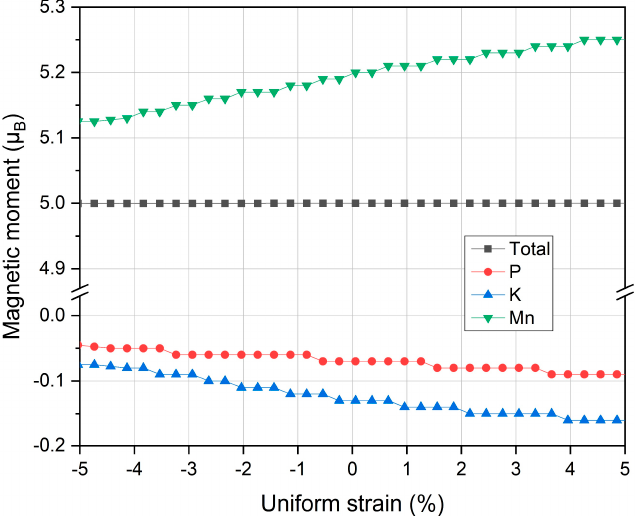
Figure 6. The calculated total and partial magnetic moments under different uniform strains for the half Heusler compound MnPK. half Heusler compound